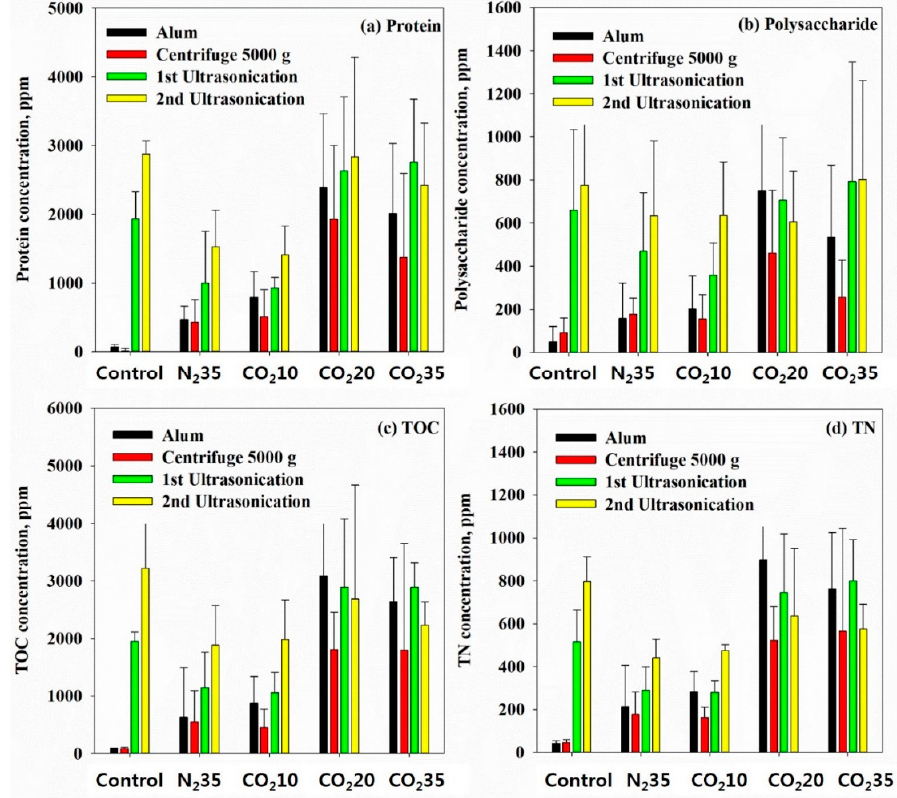
Figure14. Distributionoforganiccompoundsintheconcentratedsludge: ( a )protein; ( b )polysaccharide; Figure 14. Distribution of organic compounds in the concentrated sludge: ( a ) protein; ( b ) ( c ) TOC (total organic carbon); ( d ) TN (total organic polysaccharide; ( c ) TOC (total organic carbon); ( d ) TN (total organic nitrogen)